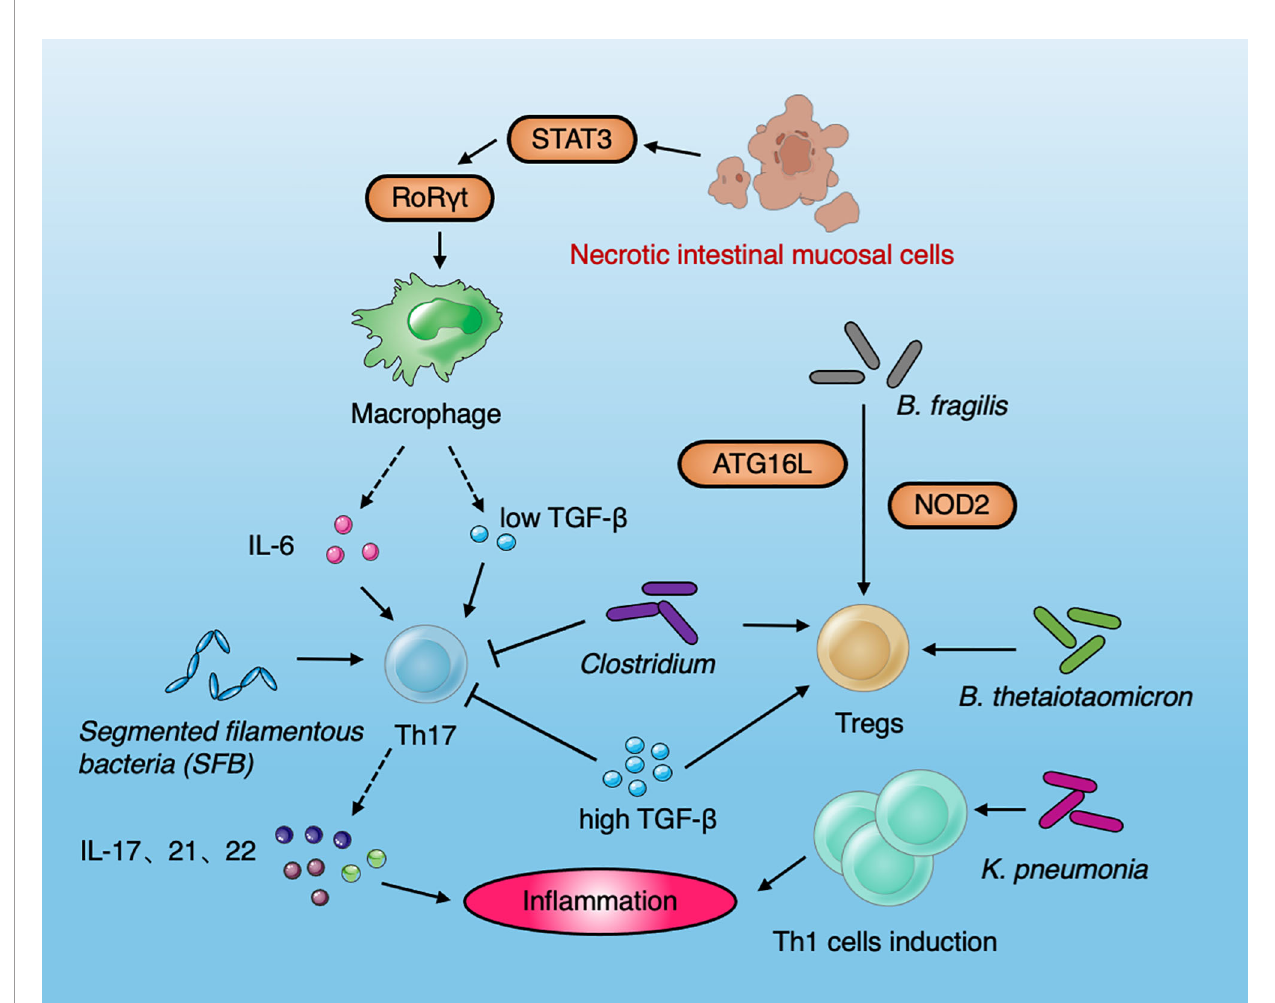
FIGURE 3 | Diagram summarizing the interaction between immune cells and the microbiota in IBD. Necrotic intestinal mucosal cells activate macrophages to produce IL-6 and TGF- b through STAT3 and ROR g t, which induce the differentiation of Th17 cells. IL-6 and low levels of TGF- b can stimulate T cells to differentiate into Th 17. High-levels of TGF- b can inhibit the production of Th 17 cells and promote the production of Treg cells. SFB can induce Th17 cells to secrete IL-17 and IL-22 and promote intestinal in fl ammation. The Clostridium spp. resulted in the production of Tregs. B. fragilis induced Tregs by the IBD-related genes Atg16L1 and NOD2. B. thetaiotaomicron recapitulate the effects of gut microbiota and induce Tregs to in fl uence the immune system in IBD. Klebsiella pneumoniae improve the induction of Th1 cell to induce the occurrence of in fl